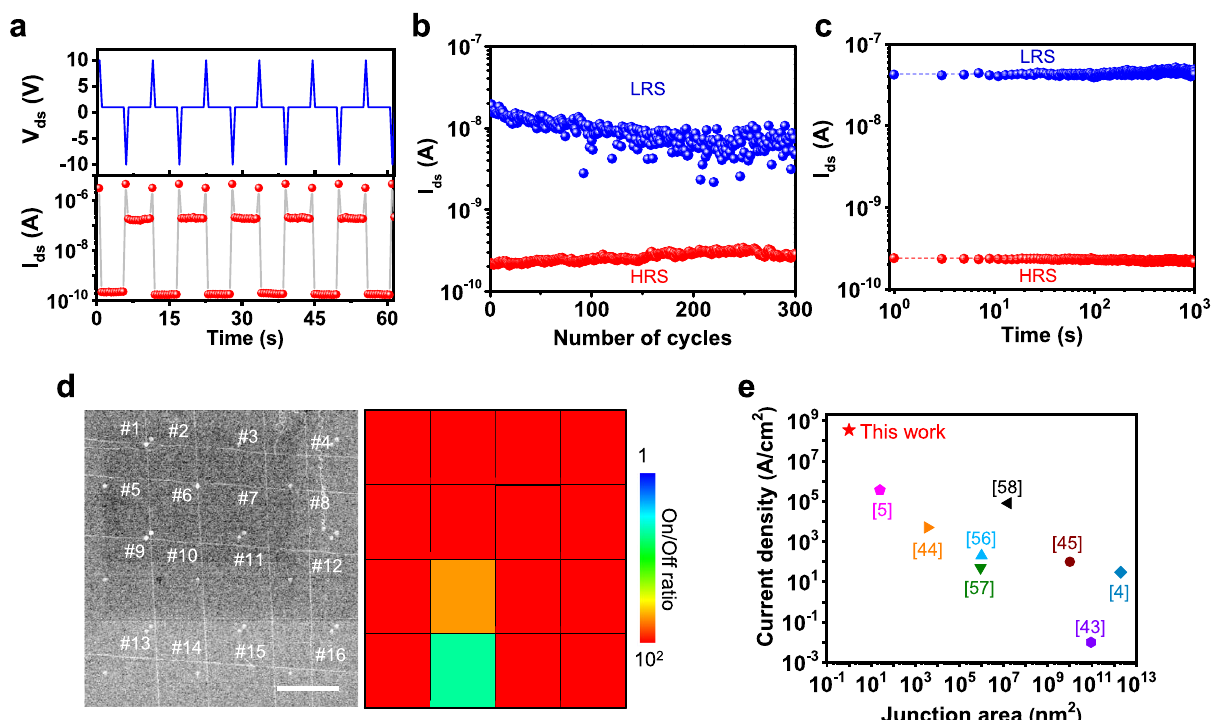
Fig. 4 | Memory function and microscale integration array of CNT B -M/CNT T vdWI. a Electrical response of CNT B -M/CNT T vdWI memory that repeats writing, reading, erasing, and reading sequence by applying a drain voltage of − 10V, 1V,+10V, and 1V, respectively. The pulse width was 0.01s. b Endurance and